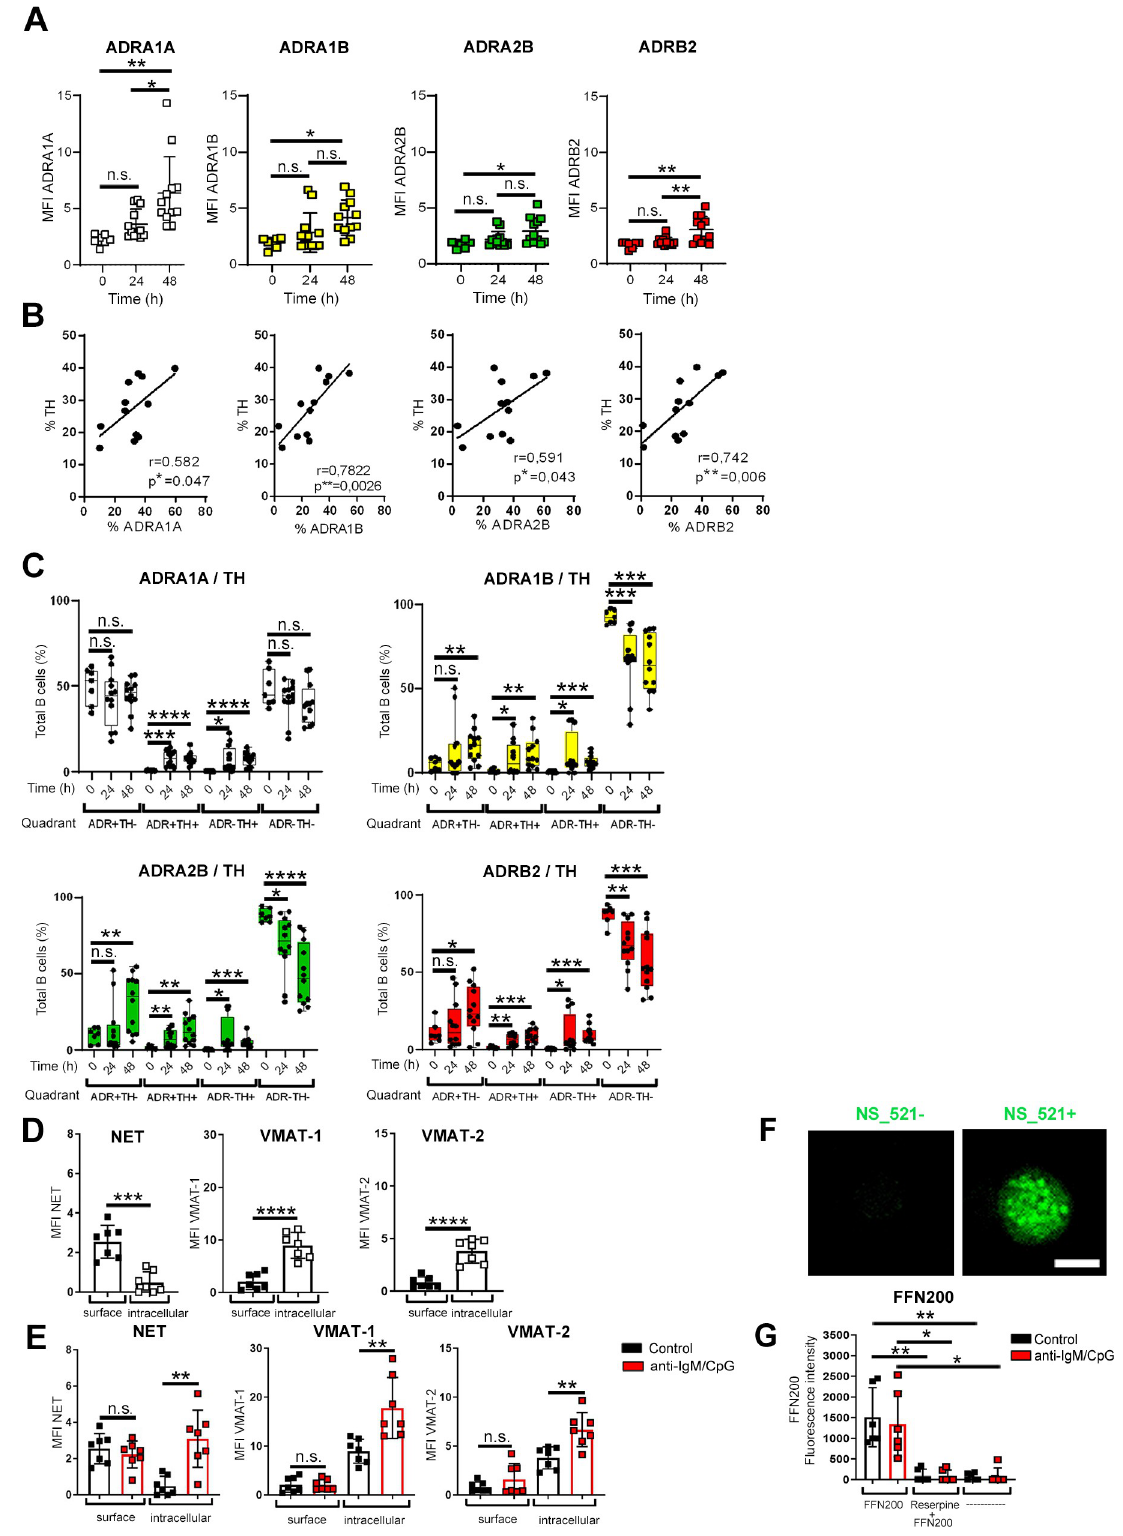
Fig 4. B cells express catecholamine receptors and transporters. ( A – C )B cells were activated with anti-IgM/CpG for 24 h and 48 h. Nonactivated B cells were used as control group (0 h). ( A ) MFI of all ADRs analyzed (0 h: n = 7; 24 h, 48 h: n = 12) was determined